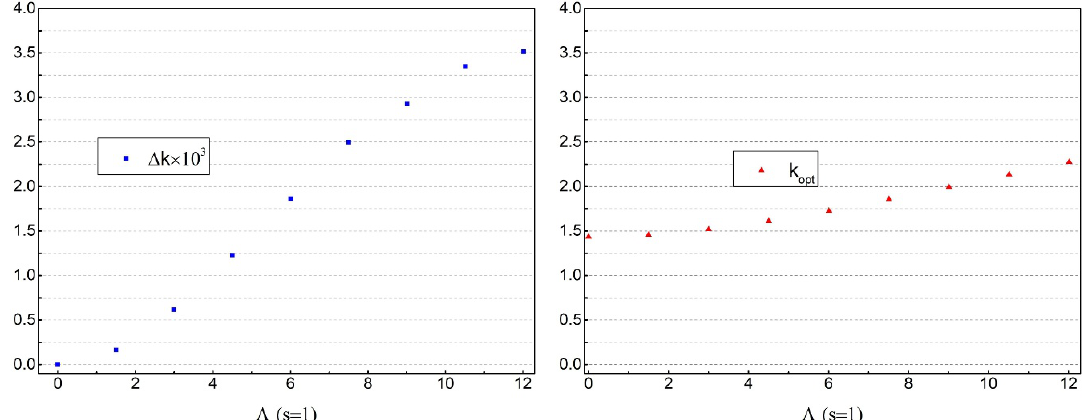
a (cid:0) . This x 0 ! 2 R